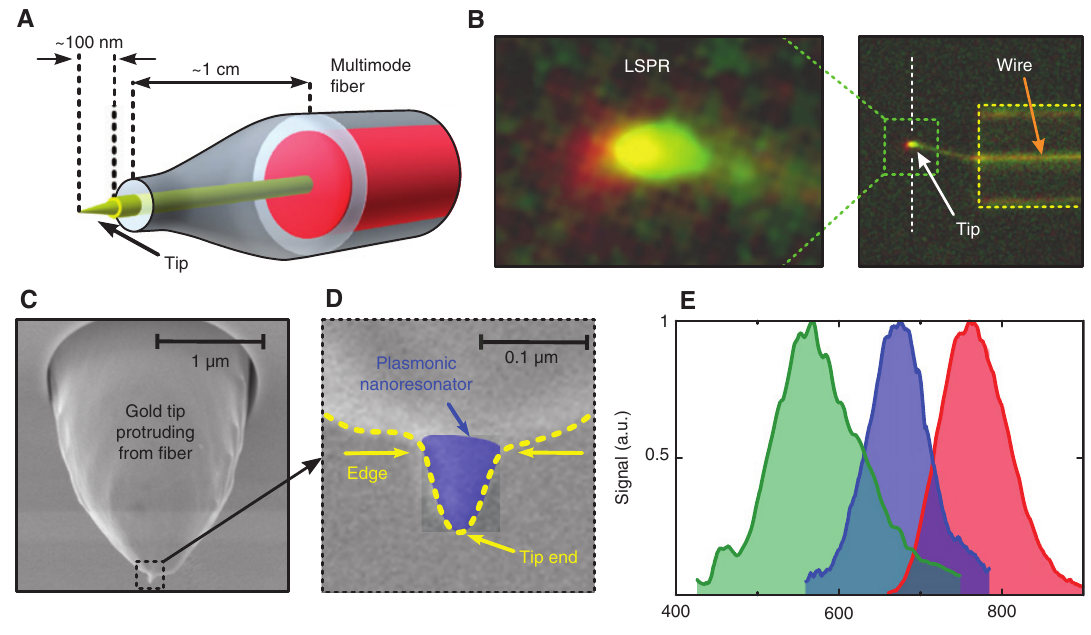
Figure 10: Fiber-based nanoprobe relying on an LSPR at the end of an integrated gold nanowire. (A) Schematic of the fiber-based near-field nanoprobe (yellow: gold nanowire; red: core of multimode fiber). (B) Microscope image of the scattered light of the plasmonic resonance when the nanoscale resonator is probing an evanescent field (right: end section of the nano- probes; yellow dashed line: boundary of fiber; white dashed line: prism-air interface; left: close-up of the excited plasmonic resonance). (C) SEM image of the gold nanowire protruding from the end of the fiber probe. The dashed green square highlights the nanoscale plas- monic resonator at the nanowire’s end. (D) Close-up of the plasmonic resonator showing the tip-on-the-tip section. The actual resonator is overlaid with a semitransparent blue area for better visibility. The edge of the resonator is highlighted by the dashed green line. (E) Normal- ized spectral distribution of the light collected at the end of the fiber device in case it probes an evanescent field that is composed of white light. Adapted from Ref. [69]. Reproduced from Ref. [69], with the permission of AIP